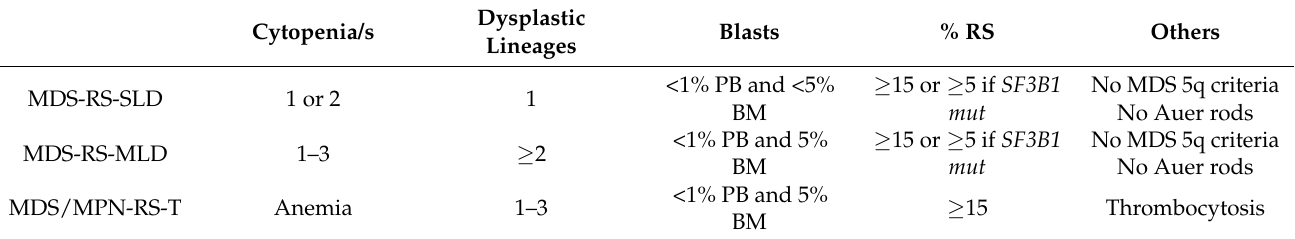
Table 2. Diagnostic criteria for clonal sideroblastic anemia (adapted from Swerdlow et al.